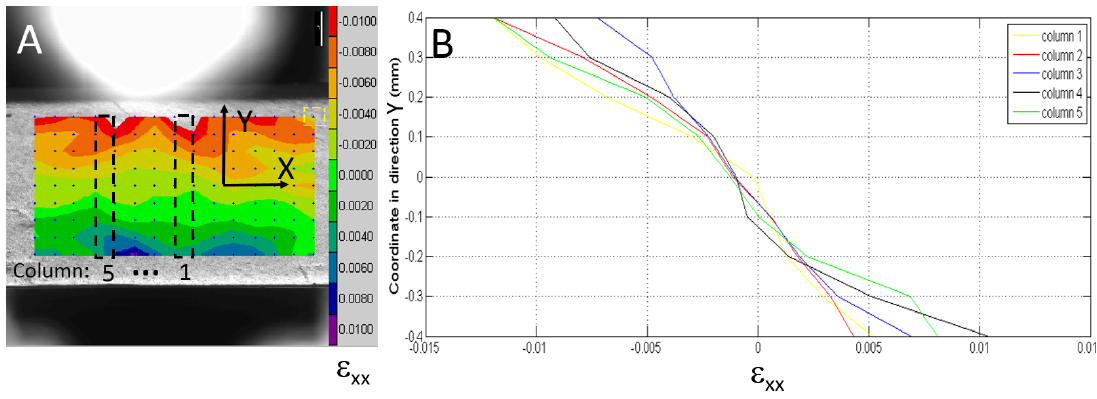
Figure 9. DIC strain distribution for intact dentin beam. ( A ) Three-point bending test and selected areas to acquire ε using DIC; ( B ) ε distribution along direction y (from xx xx